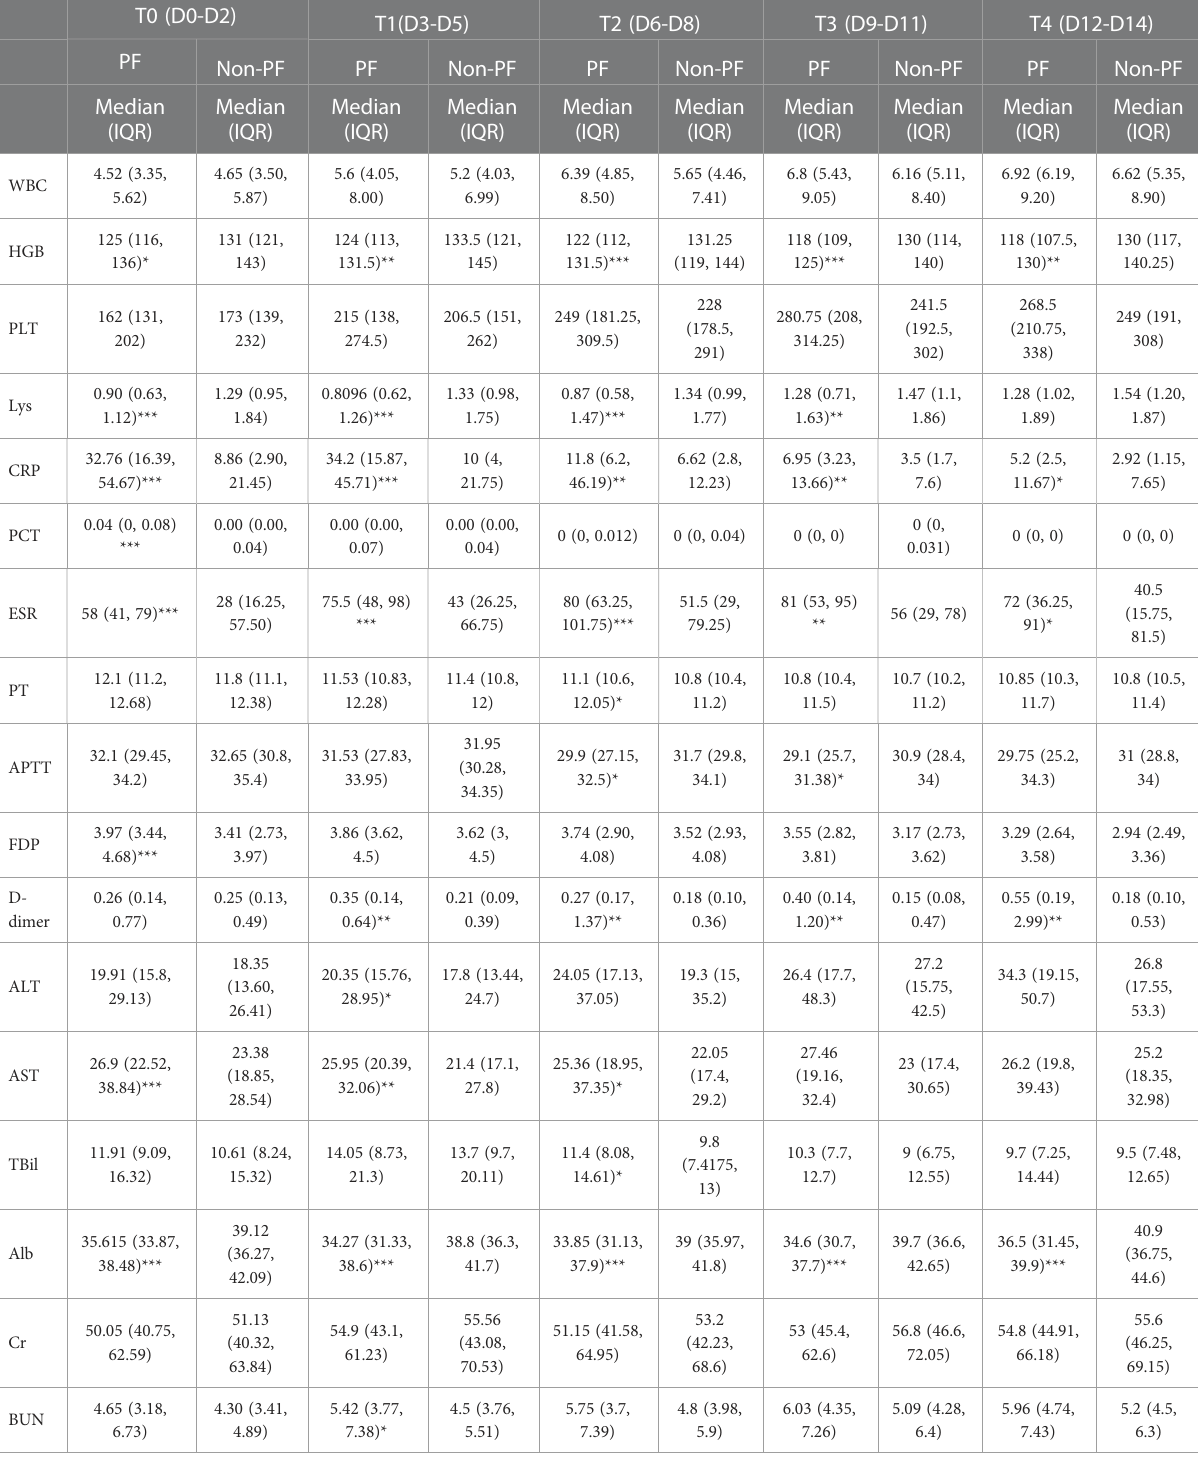
TABLE 2 Laboratory fi ndings of patients with or without pulmonary fi brosis at different time points after